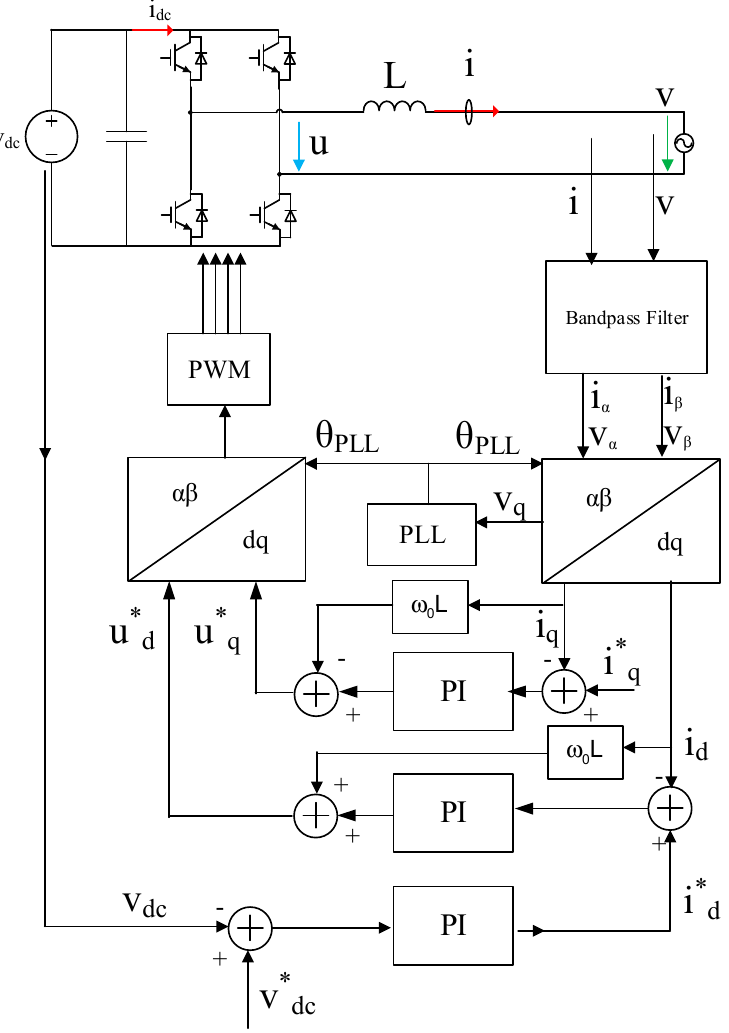
Figure 8. The block diagram of a typical synchronous rotating frame based current control inverter.